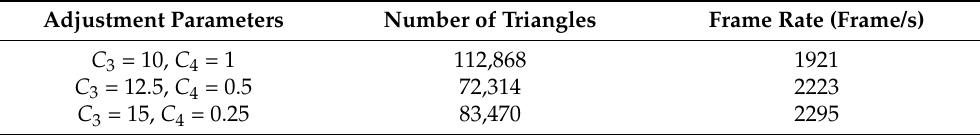
Table 3. Comparison of different adjustment